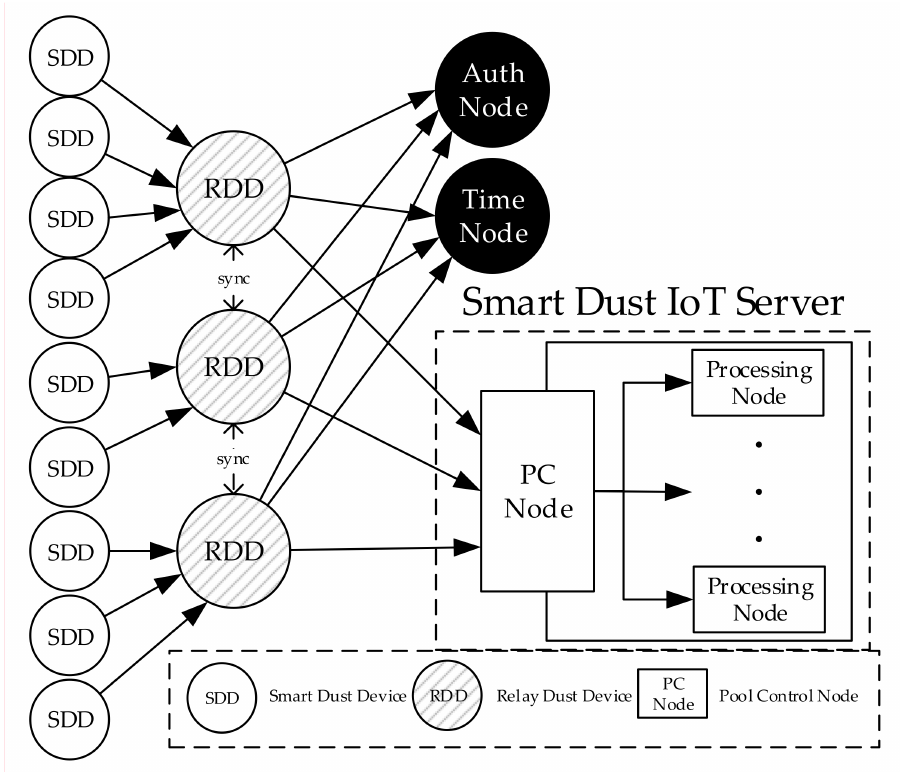
Figure 2. An overview of physical devices in a smart dust IoT environment with the lightweight blockchain.